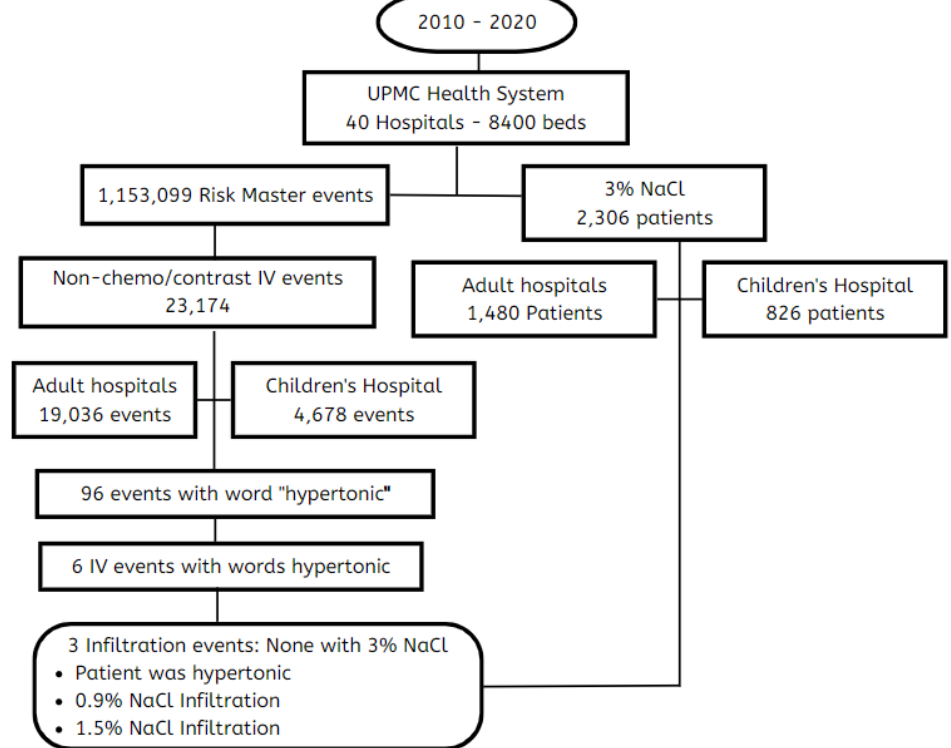
Figure 1. Health system-wide query of local intravenous reactions association with 3% NaCl. No reported infiltration reactions associated with 3% NaCl throughout the UPMC Health System in a 10-year period.